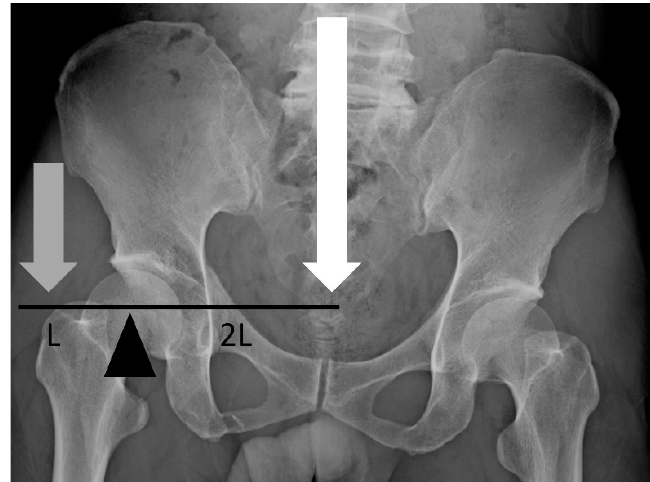
Figure 7. Coronal view of the hip illustrating the change of the lever arm around the hip’s center. When we set the hip’s center as a fulcrum, there are two opposing forces across the hip’s center: the body weight (white arrow) and abductor muscles (gray arrow). The lever arm for body weight is longer. In patients with SPD, horizontal displacement of the hip’s center often extends the lever arm for body weight, causing increased work to balance the moment.